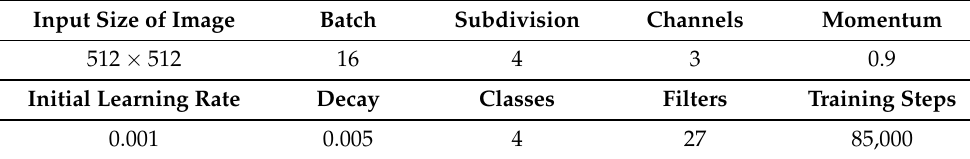
Table 3. Initial configuration parameters of improved YOLOv4